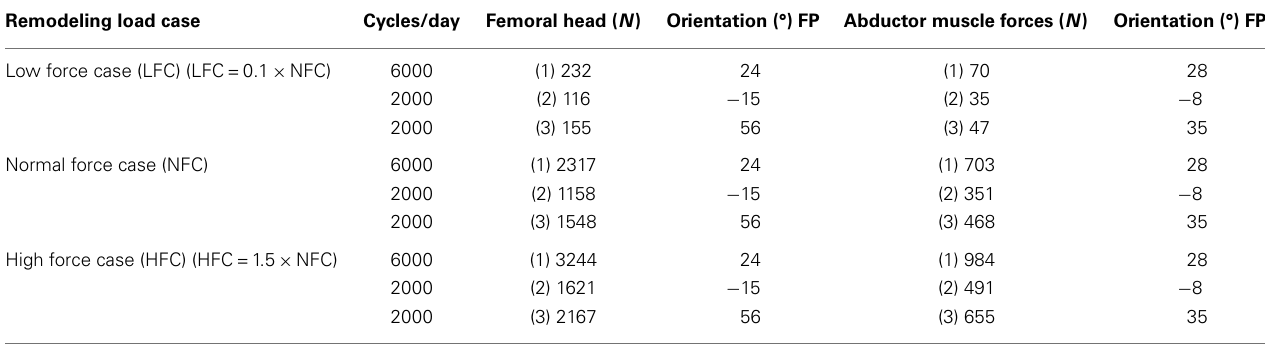
Table 2 | Selected load conditions that simulate walking under three different conditions.